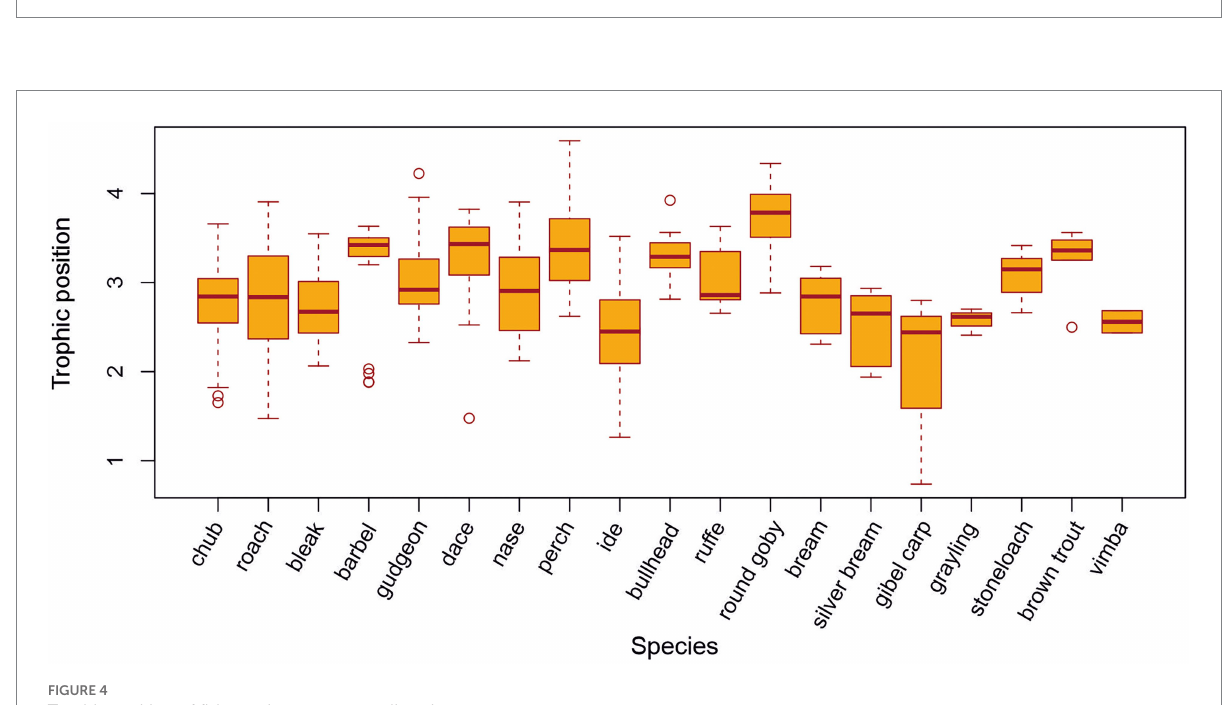
FIGURE 3 Comparison of isotopic niches of eurytopic and rheophilic ecological groups (encompassing all species and sampling sites). (A) standard ellipse area corrected (SEAc), and (B) trophic position of eurytopic and rheophilic ecological group of fish; * p <